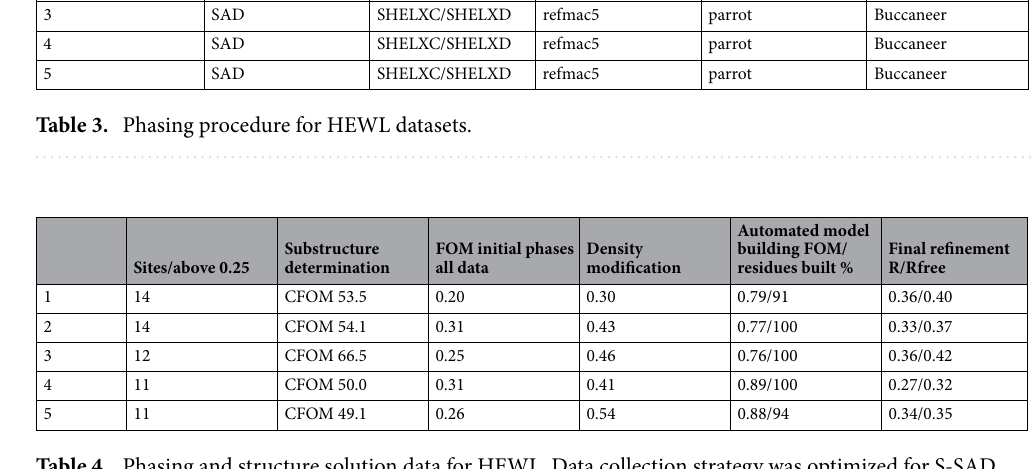
Table 4. Phasing and structure solution data for HEWL. Data collection strategy was optimized for S-SAD.